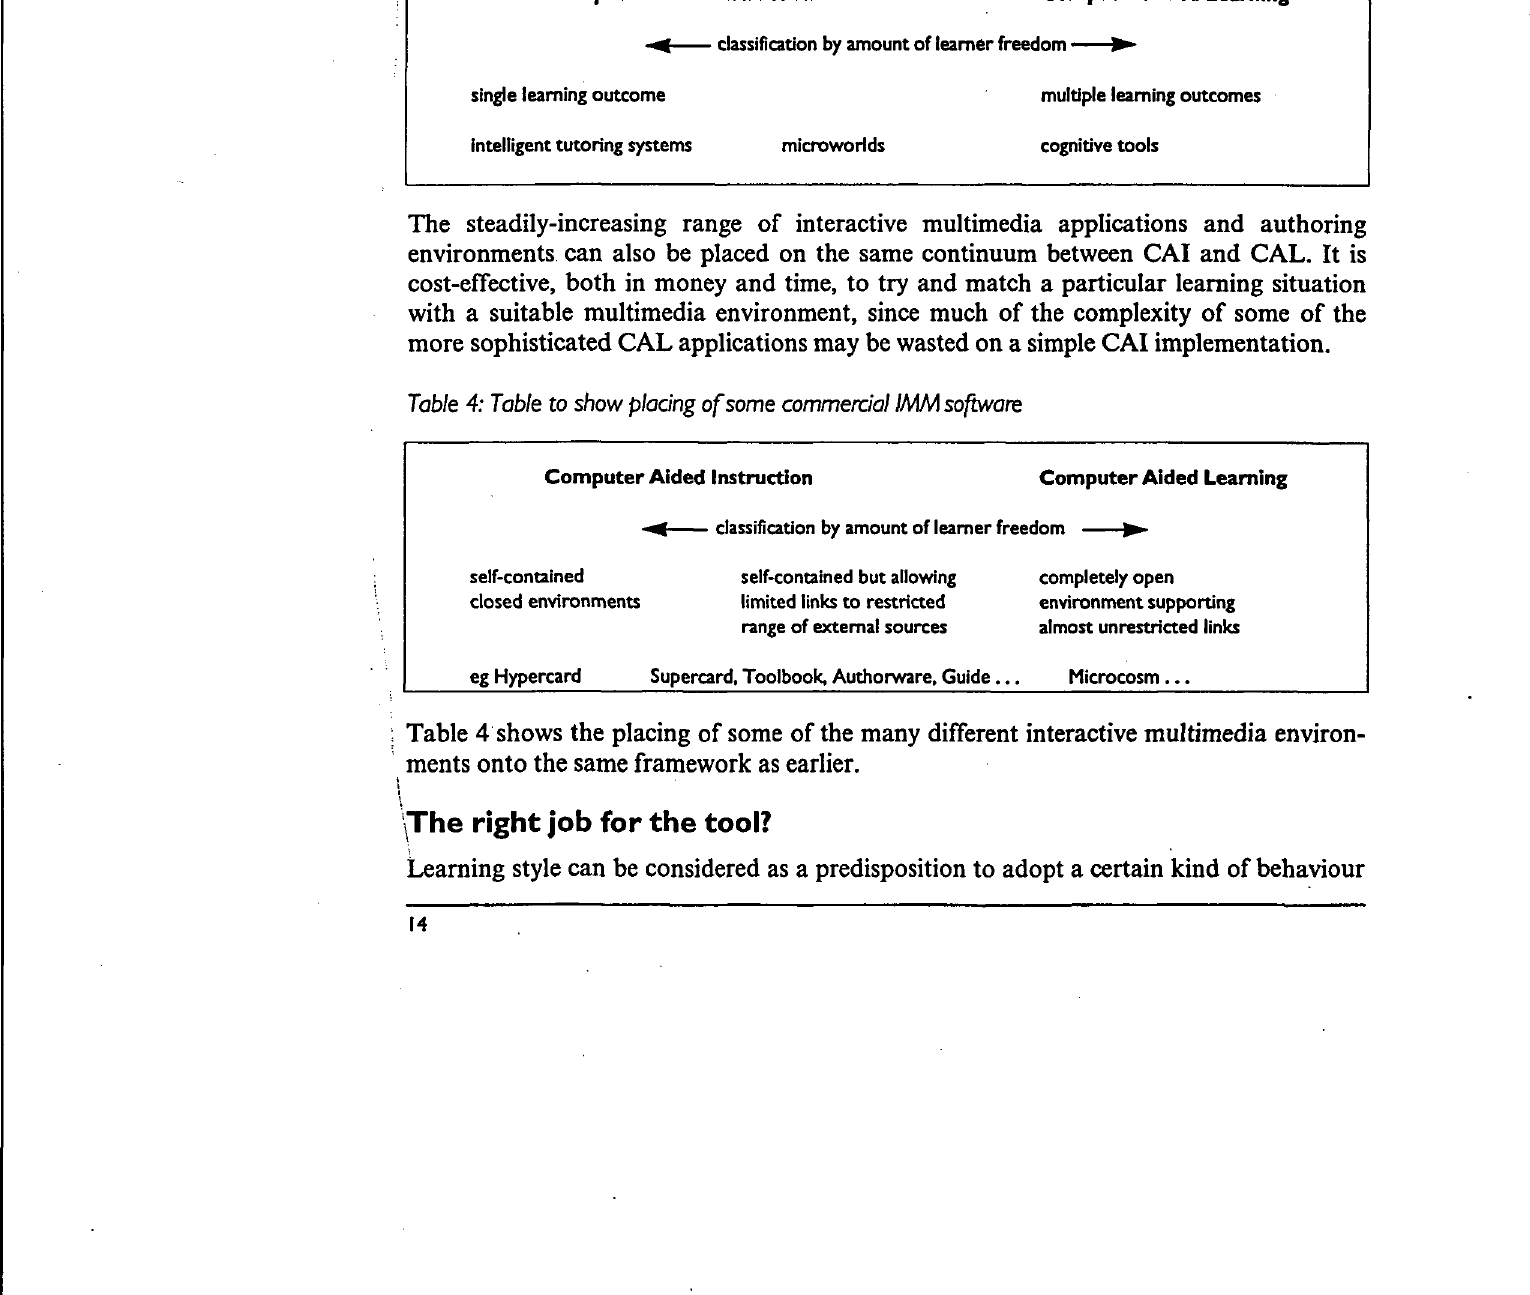
Table 3: Table to show learning outcomes and environments